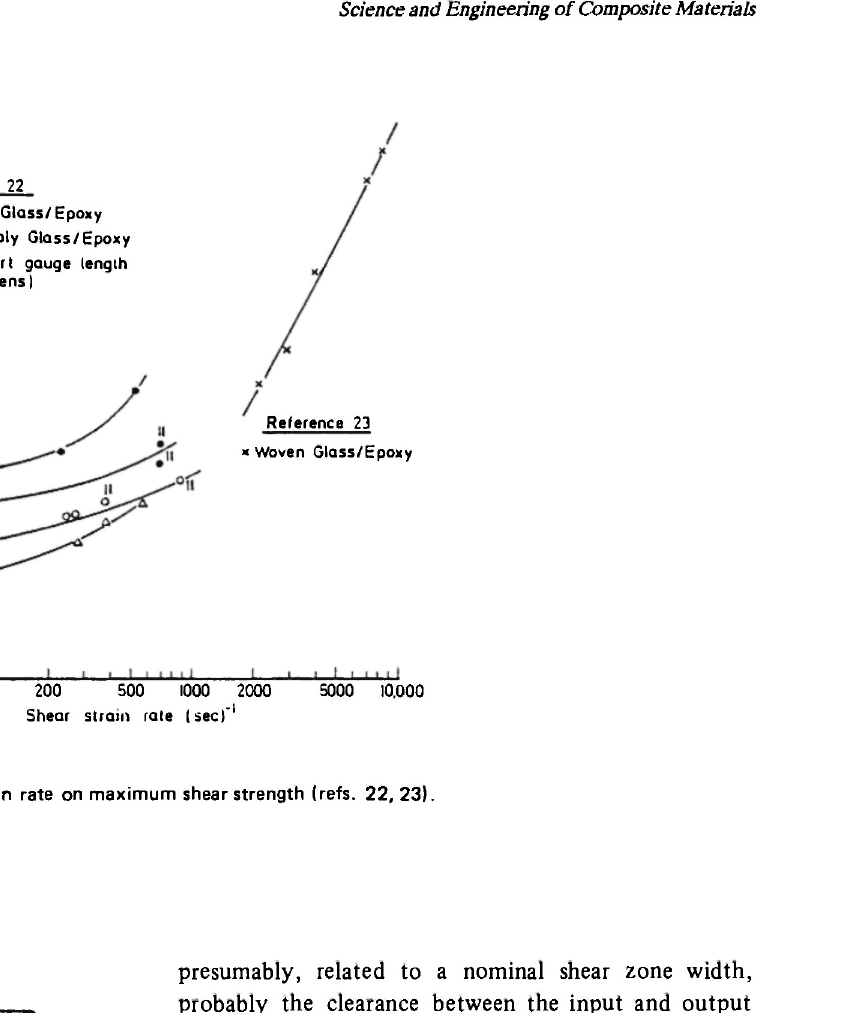
Fig. 15: Effect of strain rate on maximum shear strength (refs. 22, 23).